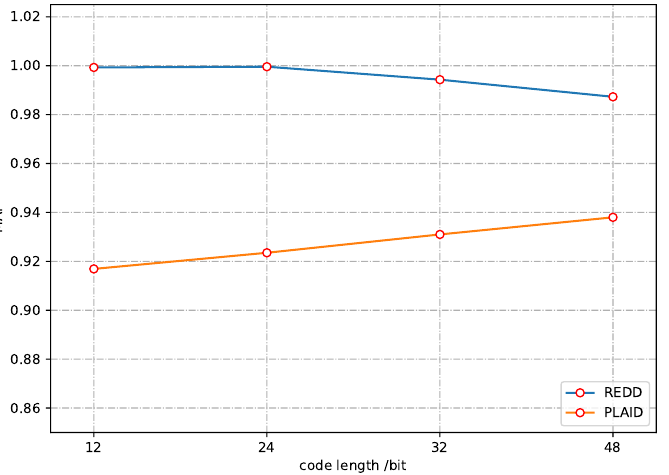
Figure 5. The mean average precision ( MAP ) of DPSH on REDD dataset and PLAID